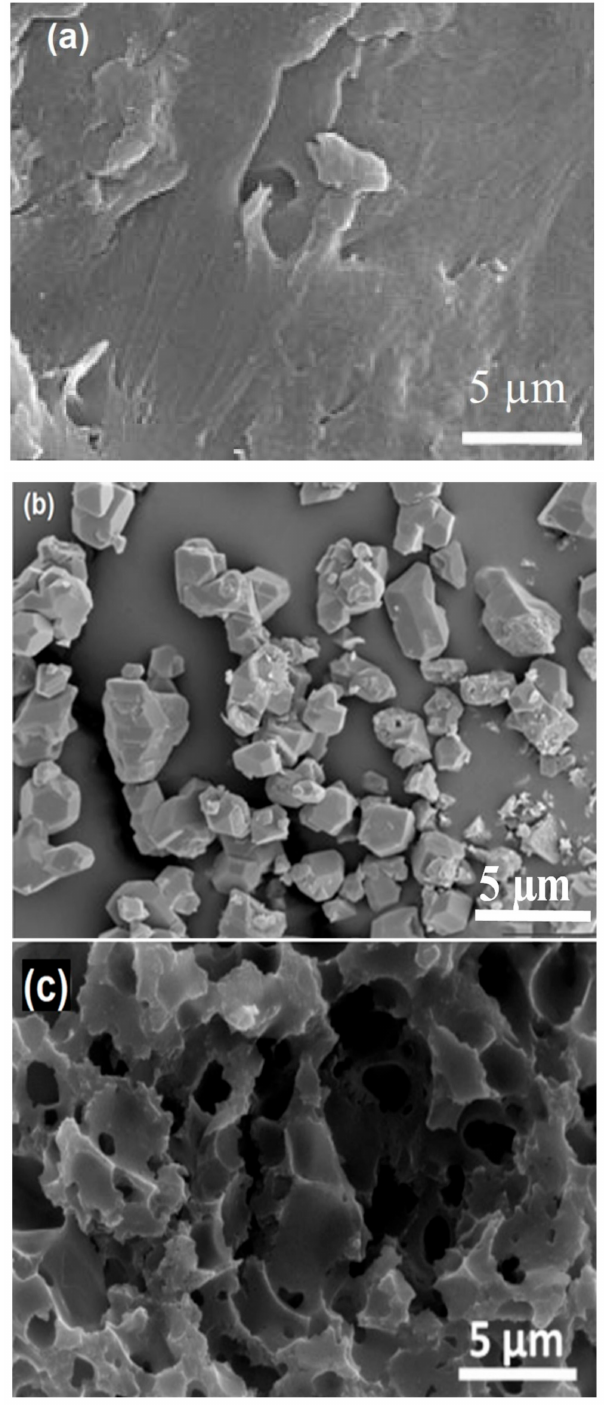
Figure 3. SEM of the CH ( a ), Zn@H 3 BTC ( b ), and CH/Zn@H 3 BTC ( c